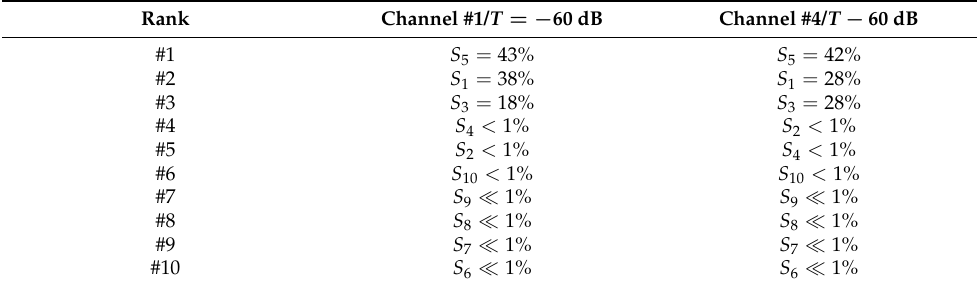
Table 4. Computed first-order Sobol’ indices ( S i , i = 1, . . . ,10) for Test case #1 (Channels #1 and